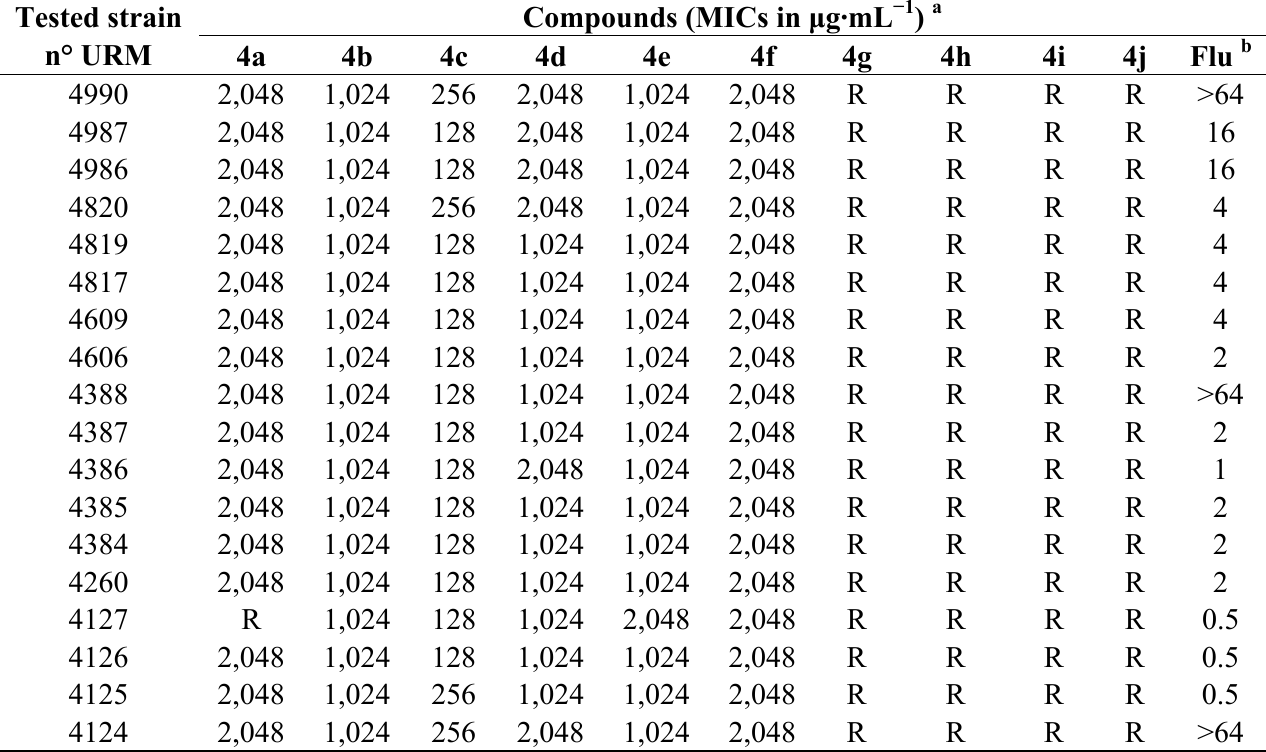
Table 1. Antifungal activity of triazoles 4a – j and fluconazole against the studied Candida strains. Tested